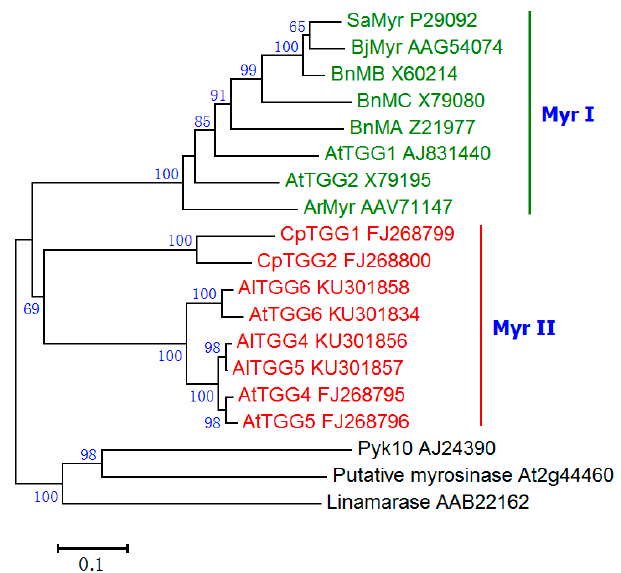
Figure 8. Evolutionary relationships of myrosinases and O - β -glucosidases. The evolutionary history was inferred using the neighbor-joining method [39]. The percentage of replicate trees in which the associated taxa clustered together in the bootstrap test (1000 replicates) are shown next to the branches [40]. Evolutionary analyses were conducted in MEGA7 [41]. The scale bar indicates 0.1 residue substitutions.